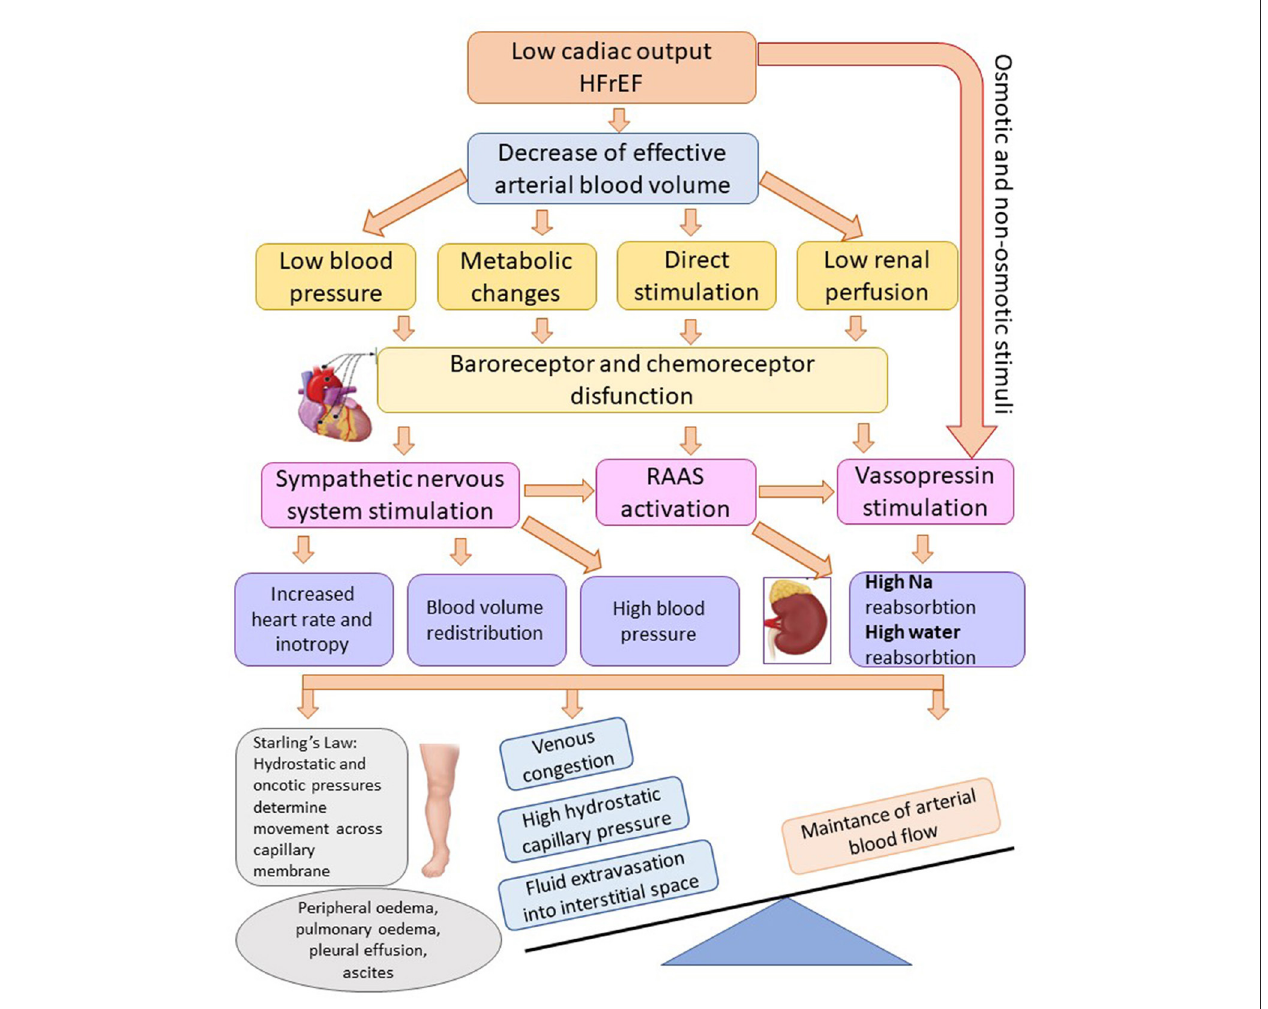
FIGURE 1 | Mechanisms of fluid overload and edema in heart failure with reduced ejection fraction. Adapted after Adams et al. (8) (HFrEF, heart failure with reduced ejection fraction; Na, sodium; RAAS, renin-angiotensin-aldosterone